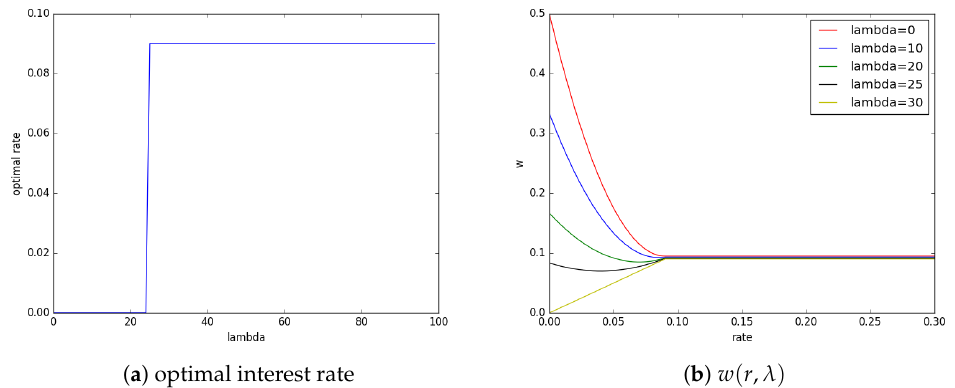
Figure 9. Optimal interest rate with N = 30 uncorrelated portfolio process: ρ 0 = 0, with µ i = σ i = 0.1 for i = 1, . . . , N .